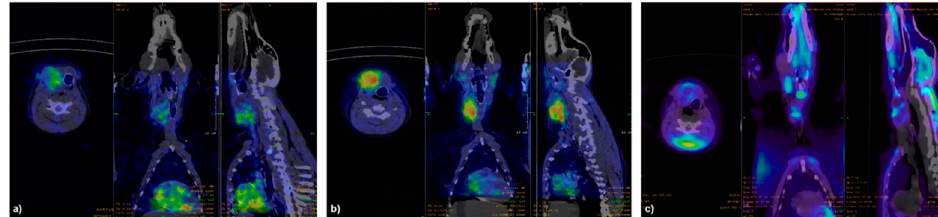
Figure 4. 99m Tc-TR1401 ( a ), 99m Tc-TR1402 ( b ), and [ 18 F]FDG ( c ) PET-CT images in dog 4 with a spontaneous trabecular/solid follicular thyroid cancer. Images clearly show high tumor uptake of 99m Tc-TR1401 and 99m Tc-TR1402 (similar to the dog in Figure 3). This dog showed the highest FDG uptake in the tumor.